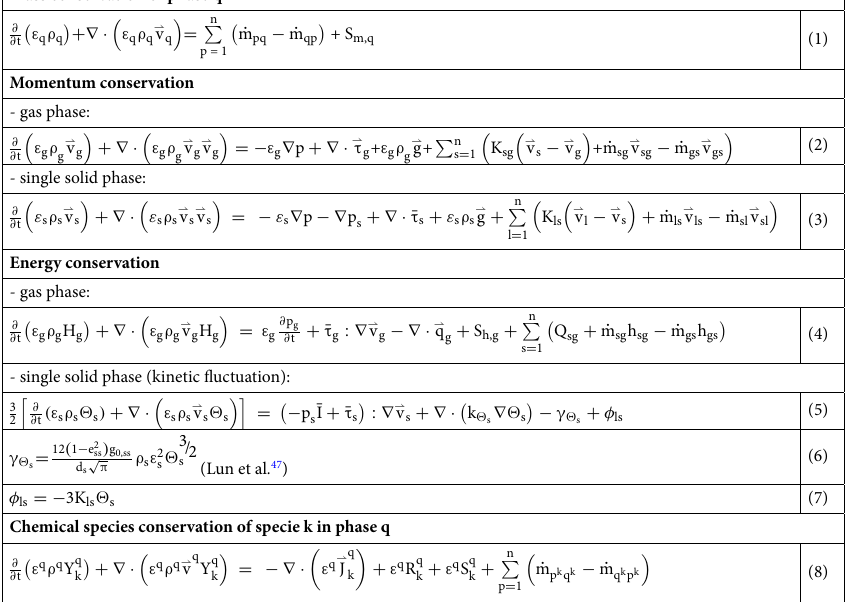
Table 1. Governing equations. Subscripts and superscripts reference: q = any single phase, p = another single phase besides q. g = gas phase, s = single solid phase, l = another single phase (gas or another solid phase) besides s. k = a specie in the